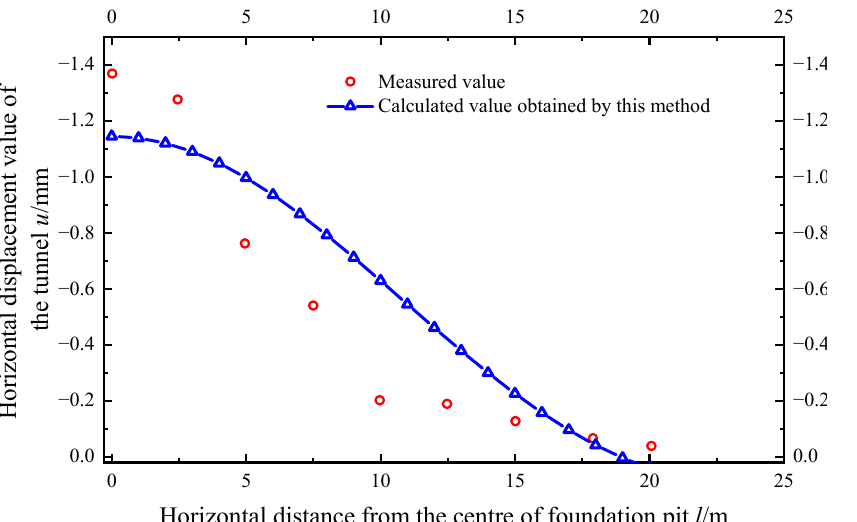
Figure 13. Comparison of the calculated and measured values of the horizontal displacement of the tunnel beside the foundation pit in case 4. There was an excavation in the vicinity of an existing tunnel of the Xinyi Line of the Taipei Metro [29]. It was carried out to a depth of 15.9 m in six stages (2.3 m, 5.5 m, 8.4 m, 11.3 m, 13.7 m, and 15.9 m). The size of the excavation is L = 59 m, B = 30 m. The down-track tunnel is only 7.3 m away from the pit at the most critical location. The buried depth of the down track tunnel is 19.15 m. The shield tunnel segment ring outer diameter D = 6 m and is lined with reinforced concreted segments of 250 mm in thickness. The site is located in the TK2 Zone of the Taipei Basin, and the subsoils comprise an alternation of silty clay and silty sand sublayers. The Poisson’s ratio of the soil was µ = 0.3 and E s = 12 MPa. Figure 14 shows the comparison curve between the calculated value and measured data of the horizontal displacement. In the calculation example, the control parameter v max / d = 0.9% of the deformation of the enclosure structure, and the rotation effect ratio coefficient j x is 0.2. As the figure shows, the maximum horizontal displacement measured is 22.21 mm, while the value calculated by the method in this paper is 29 mm.